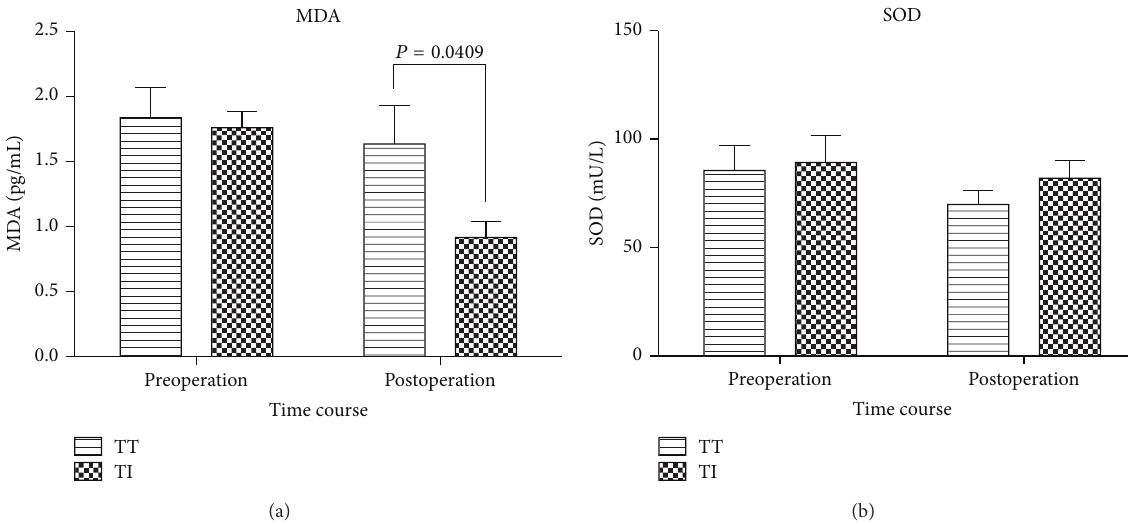
Figure 6: Changes in plasma MDA and SOD concentrations in Group TT and Group TI. Values are given as Mean ± SEM. Group TT, tracheal